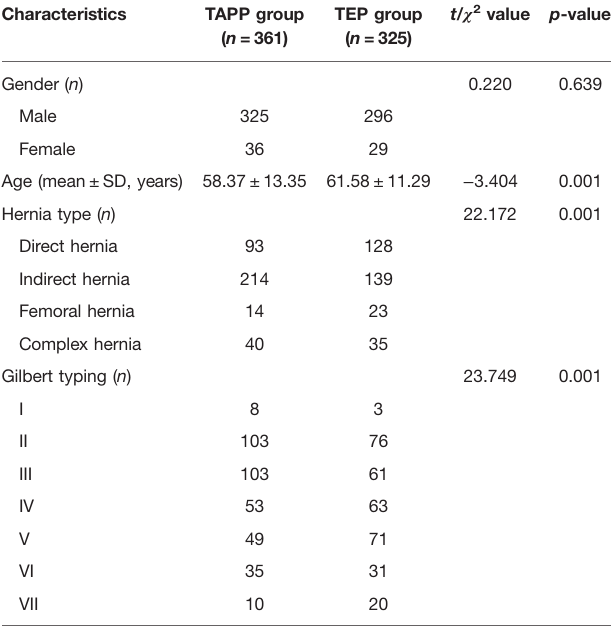
TABLE 1 | Baseline characteristics of patients in the TAPP group vs. TEP